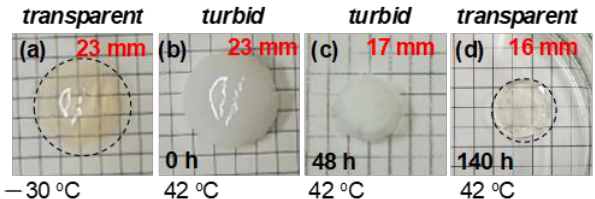
Figure 4. Photographs of P1b-gel ( a ) sufficiently swollen at −30 °C and ( b – d ) during the isothermal deswelling process at 42 °C: ( b ) immediately after changing to 42 °C, ( c ) after 48 h, and ( d ) after 140 h. The inserted value in the photographs denotes the diameter of P1b-gel. Dashed circles were drawn as visual guides for the outer shape of the gels. Each square of the grid corresponds to 5 mm.